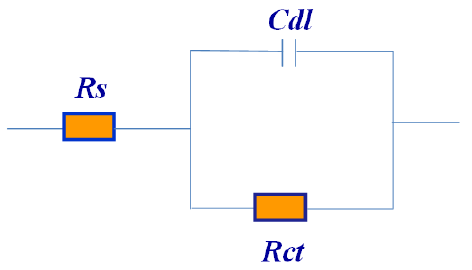
Figure 8. Equivalent circuit used to fit EIS